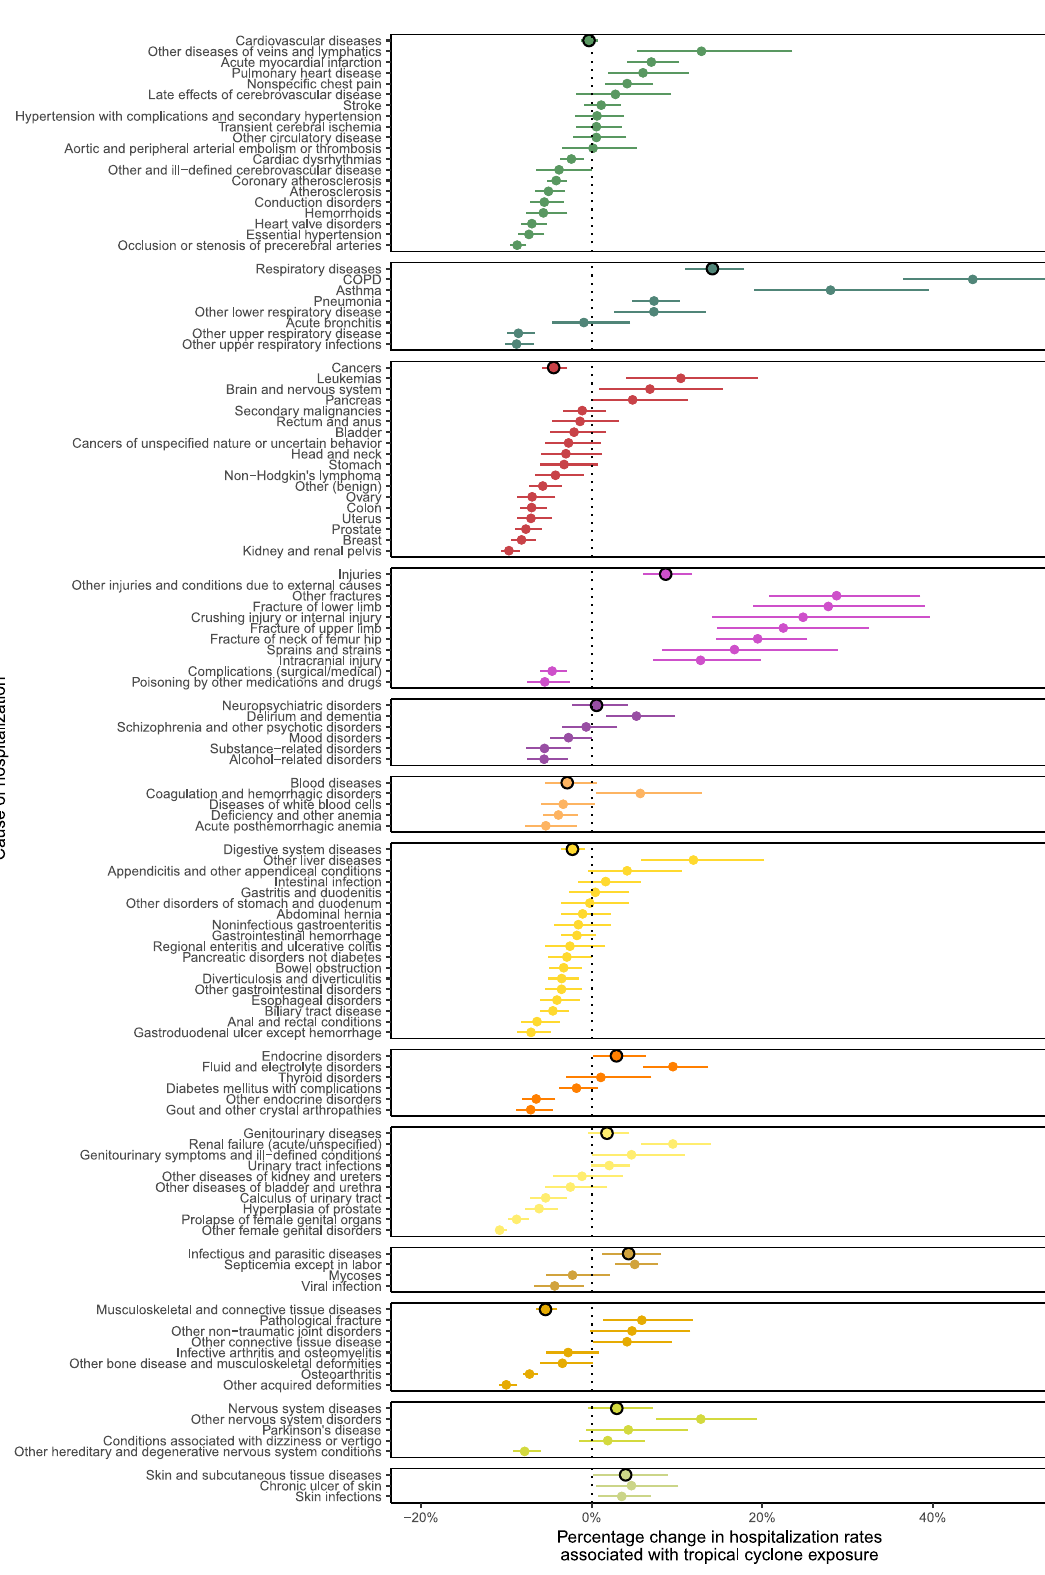
Fig. 4 Average percentage change in hospitalization rates with tropical cyclone exposure by cause and sub-cause of hospitalization. Average percentage change in hospitalization rates is across studied lag period (0 – 7 days after tropical cyclone exposure). Dots show the point estimates and error bars represent 95% con fi dence